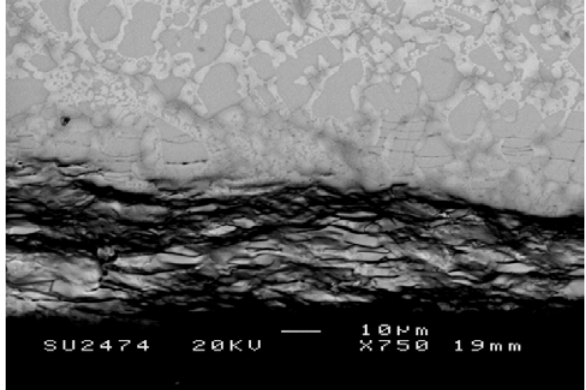
Figure 4. BSE image showing the typical microstructures of a cross-section of the alloy ZF4 after oxidation in air at 800 °C for 100 h. Table 3. The Electron Microprobe Analysis (EPMA) data of the constituent phases in the di ff usion zone and bulk of the oxidised alloy ZF4. Composition (at.%) Area Phase